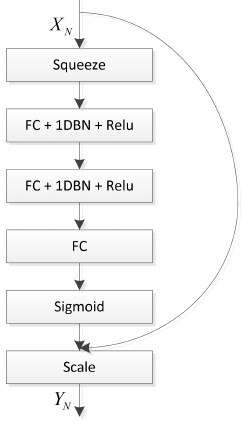
Figure 4. The architecture of NAN